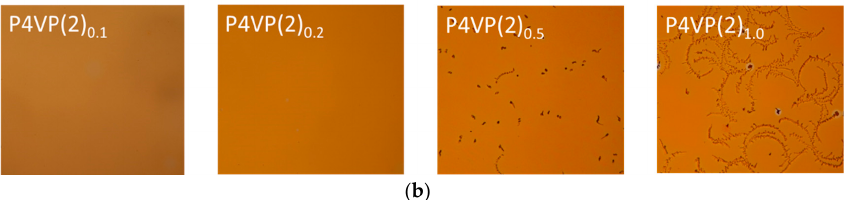
Figure 2. Optical microscope images (magnification 10×) of thin films of the halogen-bonded ( a ) P4VP( 1 ) x and ( b ) P4VP( 2 ) x complexes, with complexation degrees x equaling to 0.1, 0.2, 0.5, and 1.0. Phase separation was clearly observed at high complexation degrees, especially for the 2 -containing samples. The scale bar represents 100 μ m.